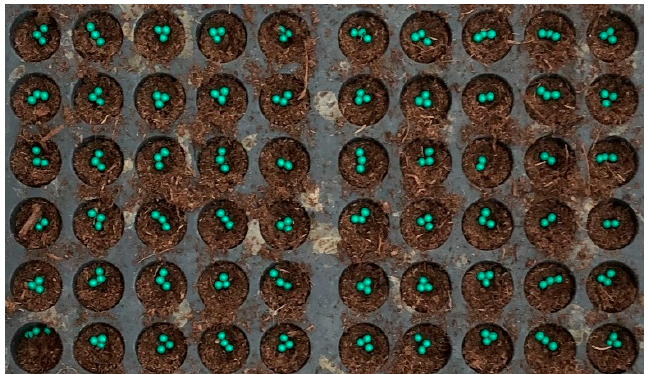
Figure 9. Schematic of the tray segment.